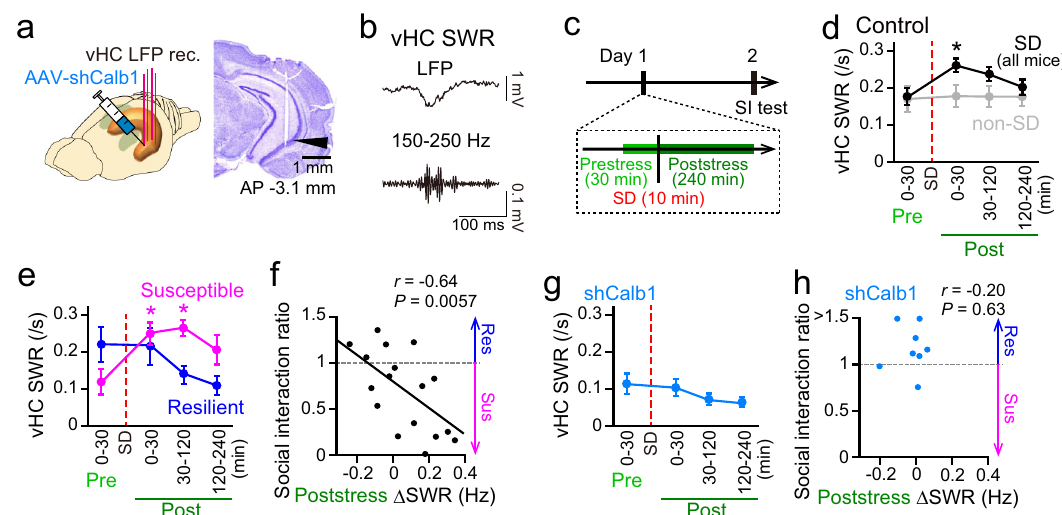
Fig. 2| PoststressventralhippocampalSWRsdifferbetweenstress-susceptible andstress-resilientmice.a (Left)LFPrecordingswereobtainedfromthevHCafter injectionofAAV-shCalb1.(Right)Histologicalcon fi rmationofarecordingsiteinthe vHC CA1cell layer in a cresyl-stained section. The arrowhead indicates the track of the electrode. The same results were obtained from 72 mice with electrodes implantedinthevHC. b Un fi lteredandbandpass- fi ltered(150 – 250Hz)LFPtracesof a representative ventral hippocampal SWR. c Schematic illustration of the recording time course. The difference in poststress neuronal activity between the prestress and 0 – 2h poststress period was computed on day 1, and several mice weresubjectedtoanSItestonday2. d Changesintheratesofventralhippocampal SWRs in SD mice (black, n =23 mice). For comparison, the same recordings were performed for non-SDmice(gray, n =6mice).0 – 30-minpre versus 0 – 30-min post periods, Z =2.65, * P =0.024, two-sided Mann – Whitney U test followed by